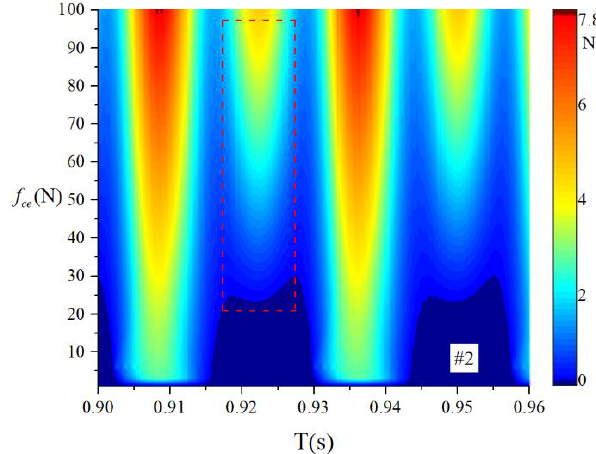
Figure 20. Waterfall of the rolling element – raceway contact force (#2).